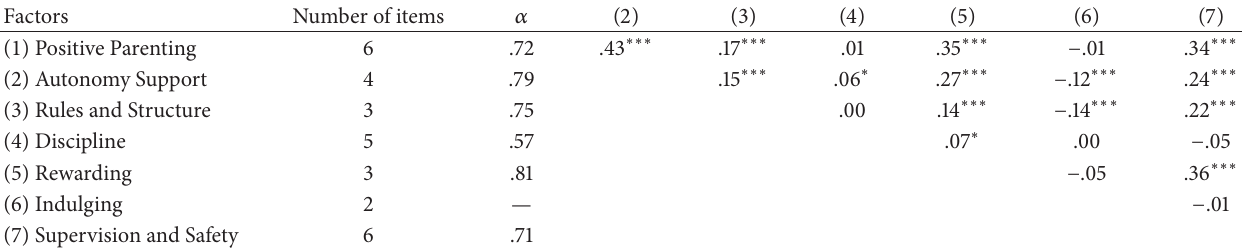
Table 1: Number of items and 𝛼 values for all the factors and their intercorrelations (Pearson’s correlations). Factors